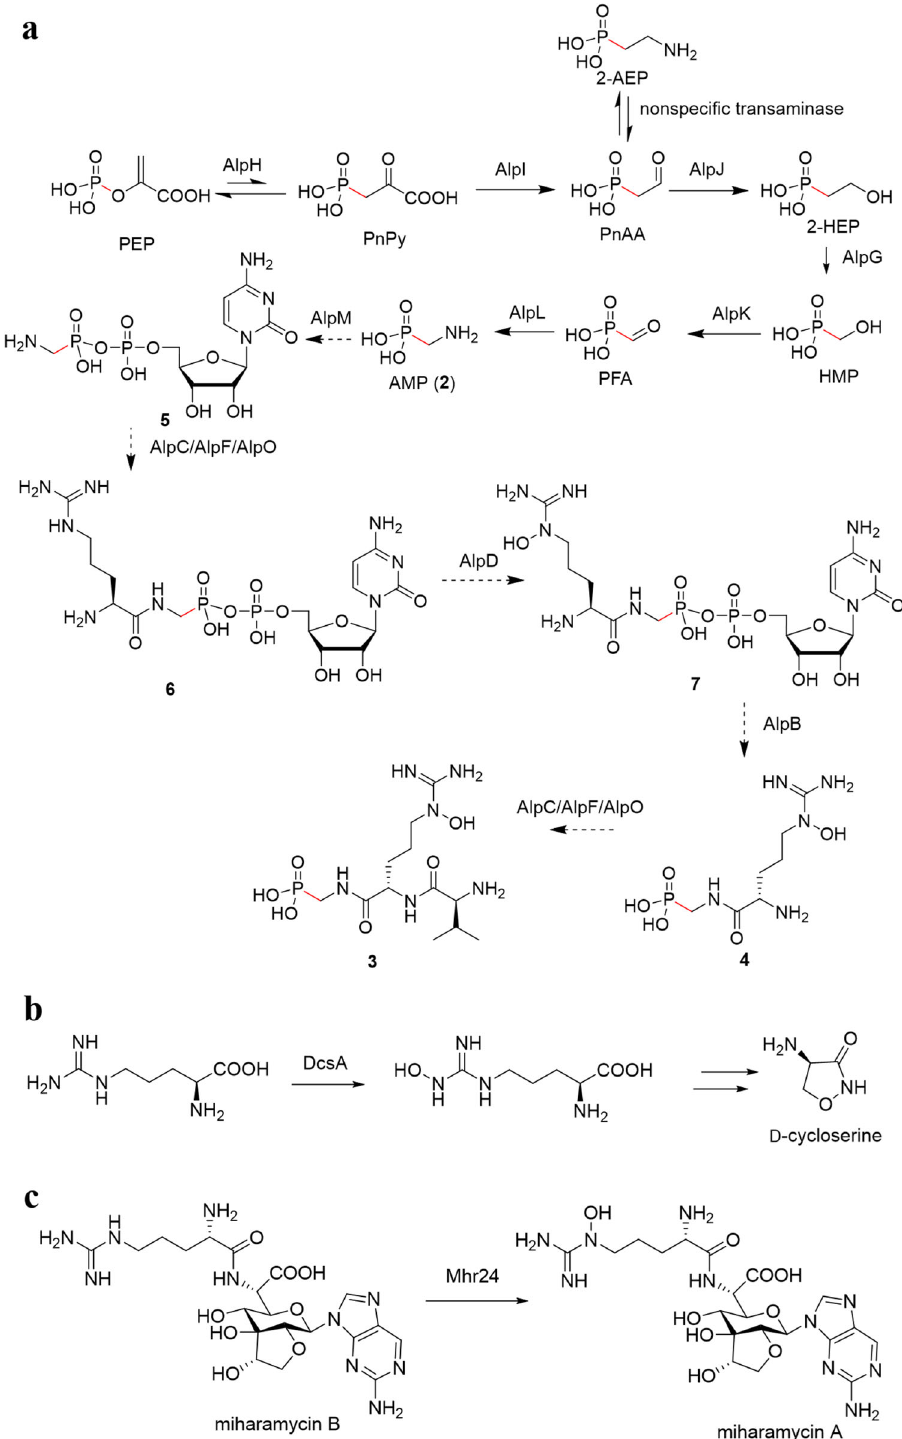
Fig. 4 Biosynthesis of the phosphonate antibiotic argolaphos A (3). a Proposed biosynthetic pathway of argolaphos A ( 3 ). Putative steps are indicated with dashed arrows. PEP phosphoenolpyruvate, PnPy phosphonopyruvate, PnAA phosphonoacetaldehyde, 2-HEP 2-hydroxyethylphosphonate, HMP hydroxymethylphosphonate, PFA phosphonoformaldehyde. b DcsA is the proposed hydroxylase involved in arginine N ω -oxidation in the biosynthesis of D -cycloserine. c Mhr24 is a hydroxylase in the oxidation of arginine N 5 of miharamycin B to yield miharamycin